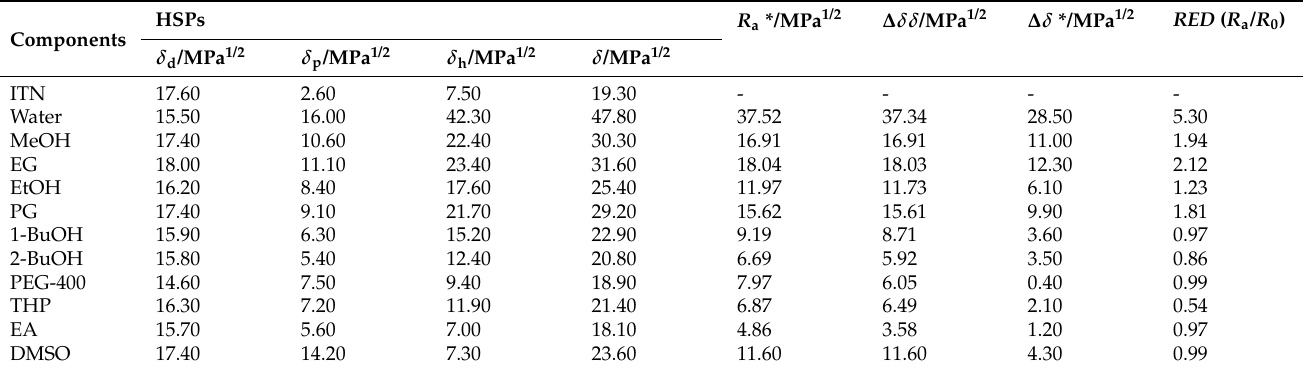
Table 2. Several solubility parameters of ITN and eleven distinct green solvents at 298.2